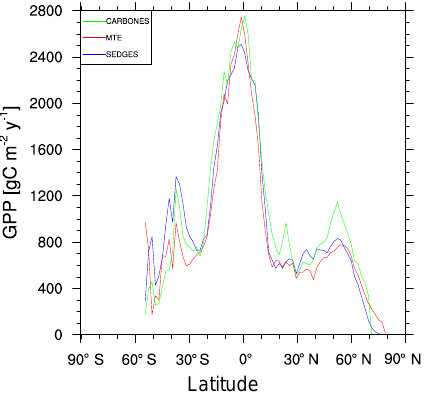
Figure 5. Zonal multiyear annual mean of GPP for SEDGES and the two reference datasets, MTE and CARBONES, for 1990–2009 over non-glaciated land.